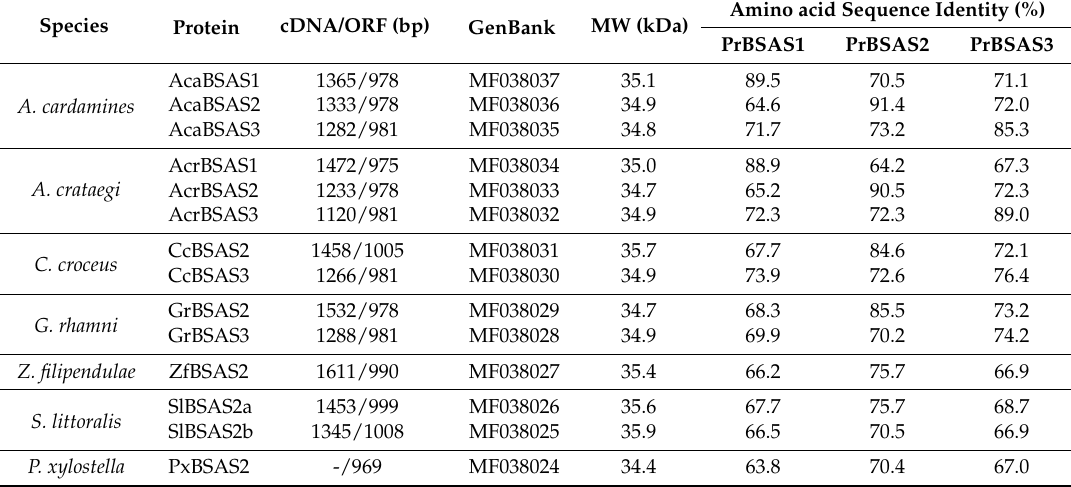
Table 1. β -substituted alanine synthases (BSAS) identified from lepidopteran species. Listed are BSAS which have been identified in this study and characterized as β -cyanoalanine synthases. The length of the obtained cDNA sequence and the ORF is also given together with the GenBank accession number, and the calculated molecular weight (MW) of the encoded protein